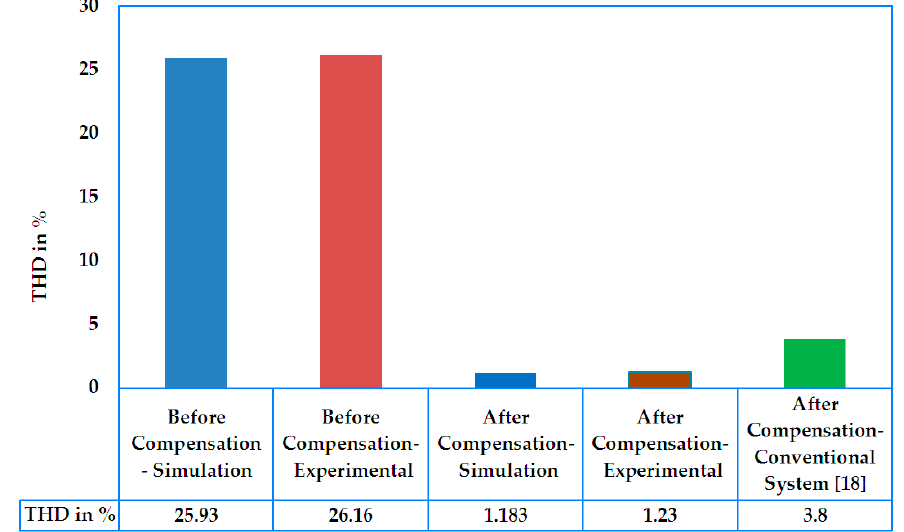
Figure 28. THD level of source current before and after compensation during the simulation and experimental study and THD level after compensation in the conventional system.